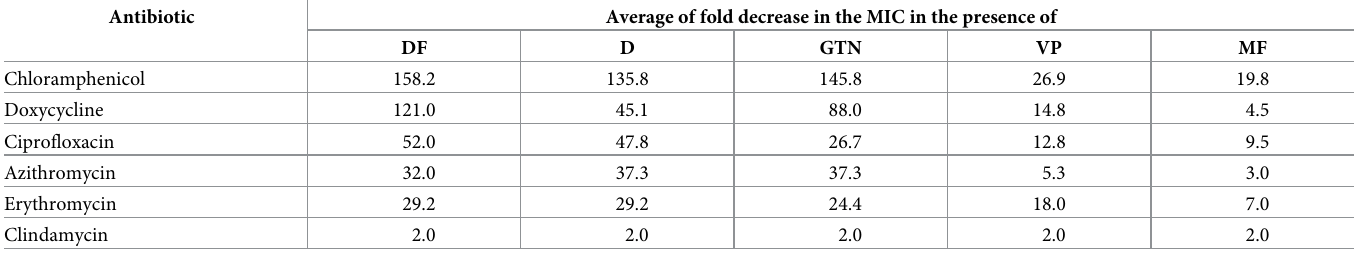
Table 5. Averages of the fold decreases in the MICs of tested antibiotics in the presence of the tested compounds.